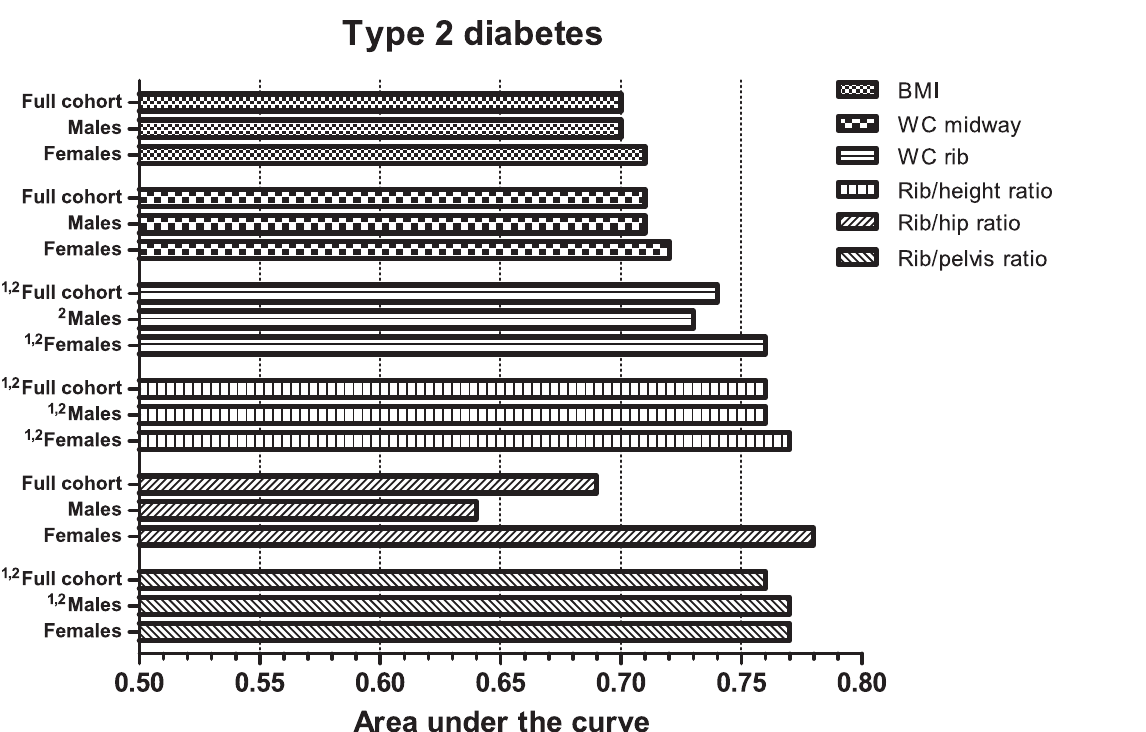
Fig 4. Adjusted area under the receiver operating characteristic curve values for selected obesity measures to discriminate subjects with type 2 diabetes. Bars represent AUC values. Statistical differences in the AUC values are shown in superscript Arabic numbers as: 1 P < 0.05 compared to WC midway; 2 P < 0.05 compared to BMI.